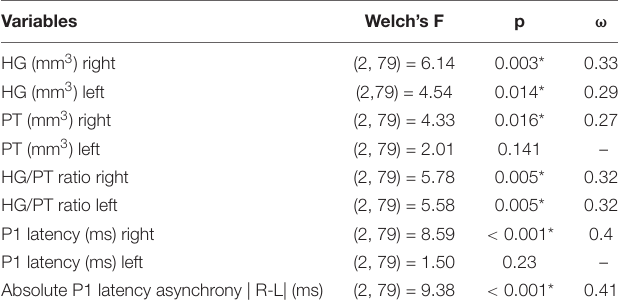
TABLE 3 | Welch’s F -test ANOVA MRT and MEG